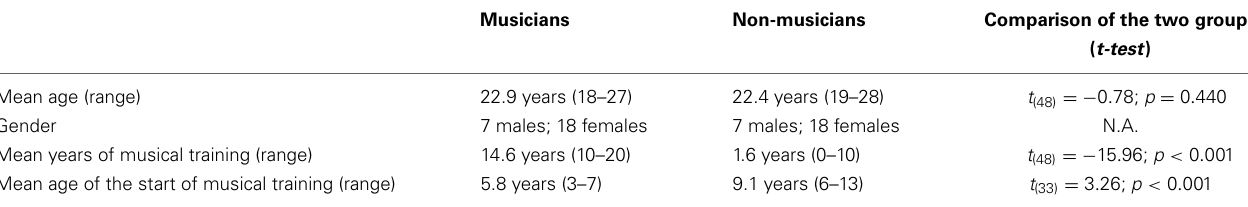
Table 1 | Demographics of the